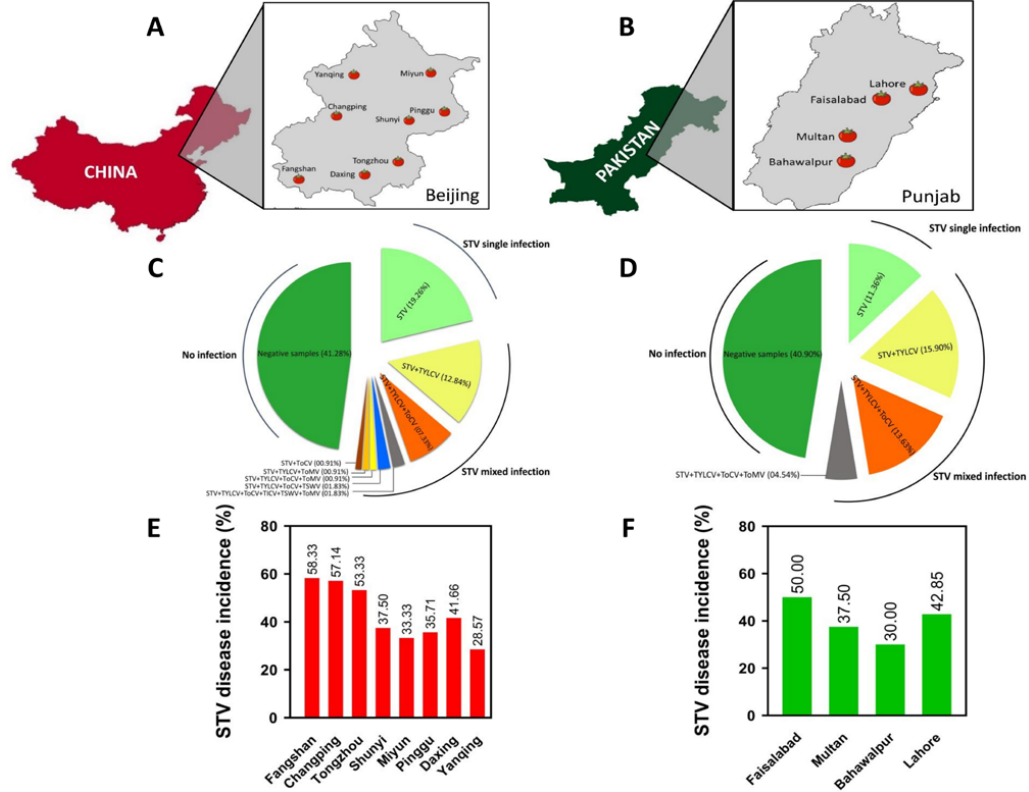
Figure 2. The geographical studies of STV with its diagnosis and infection dynamics. ( A , B ) The geographical locations of disease-symptomatic tomato samples collected from Beijing, China, and Punjab, Pakistan. Sampled sites are marked on the enlarged abridged maps. ( C , D ) The infection dynamics of STV in single- and mixed-infection conditions with multiple combinations of viruses. ( E , F ) The confirmed STV disease incidence recorded across Beijing, China ( E ), and Punjab, Pakistan ( F ).